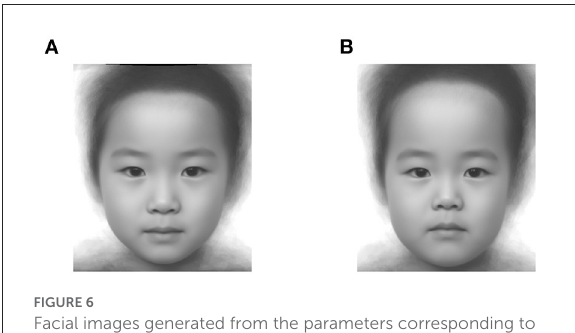
FIGURE6 Facial images generated from the parameters corresponding to (A) the maximum (PC1: -0.8, PC2: -0.4, PC3: 0.8) and (B) the minimum of the averaged utility function of cuteness (PC1: 0.0, PC2: 0.4, PC3: −